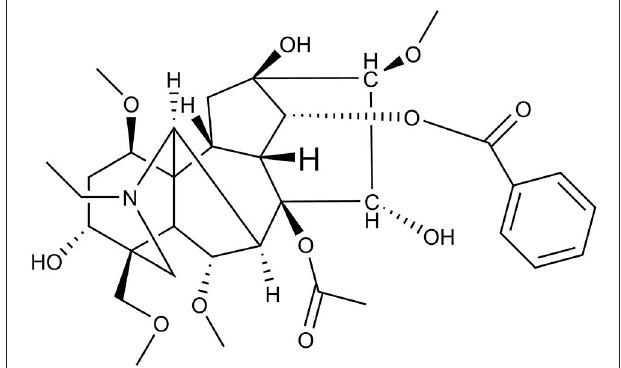
FIGURE 1 | The chemical structure of